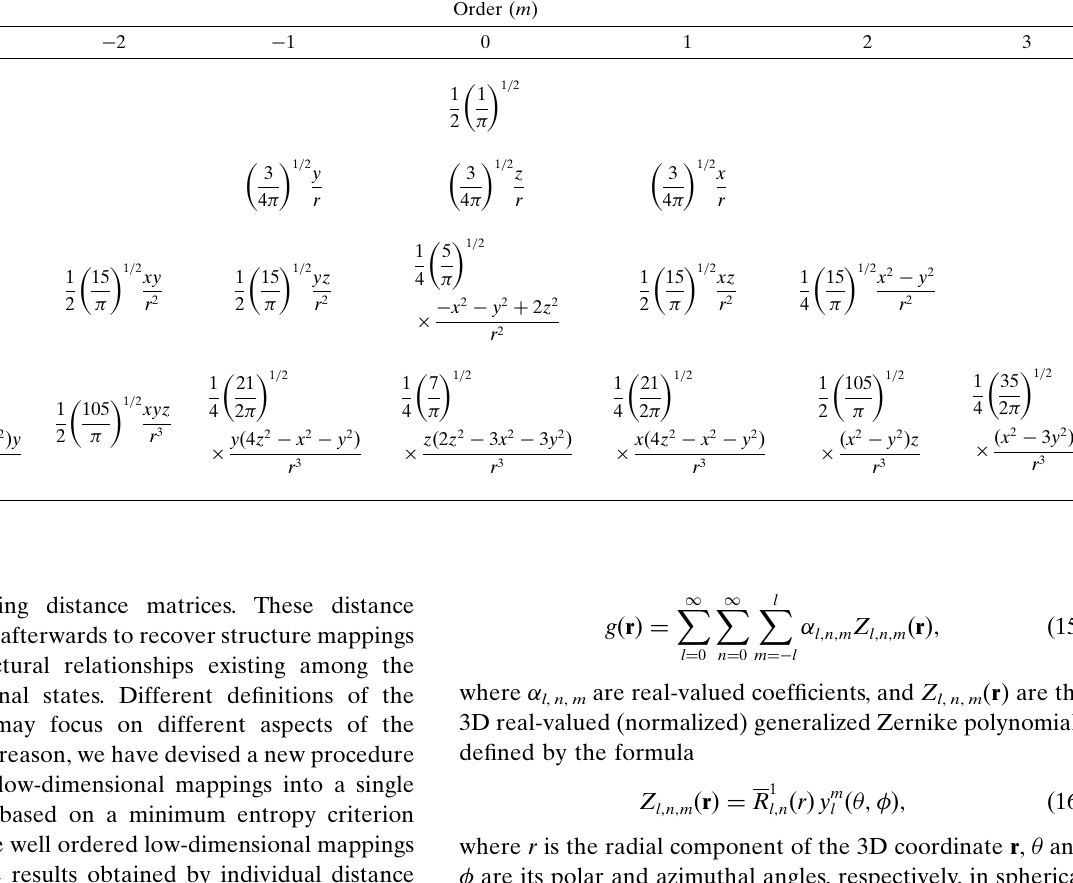
Table 1 List of real-valued spherical harmonics y m Degree ( l